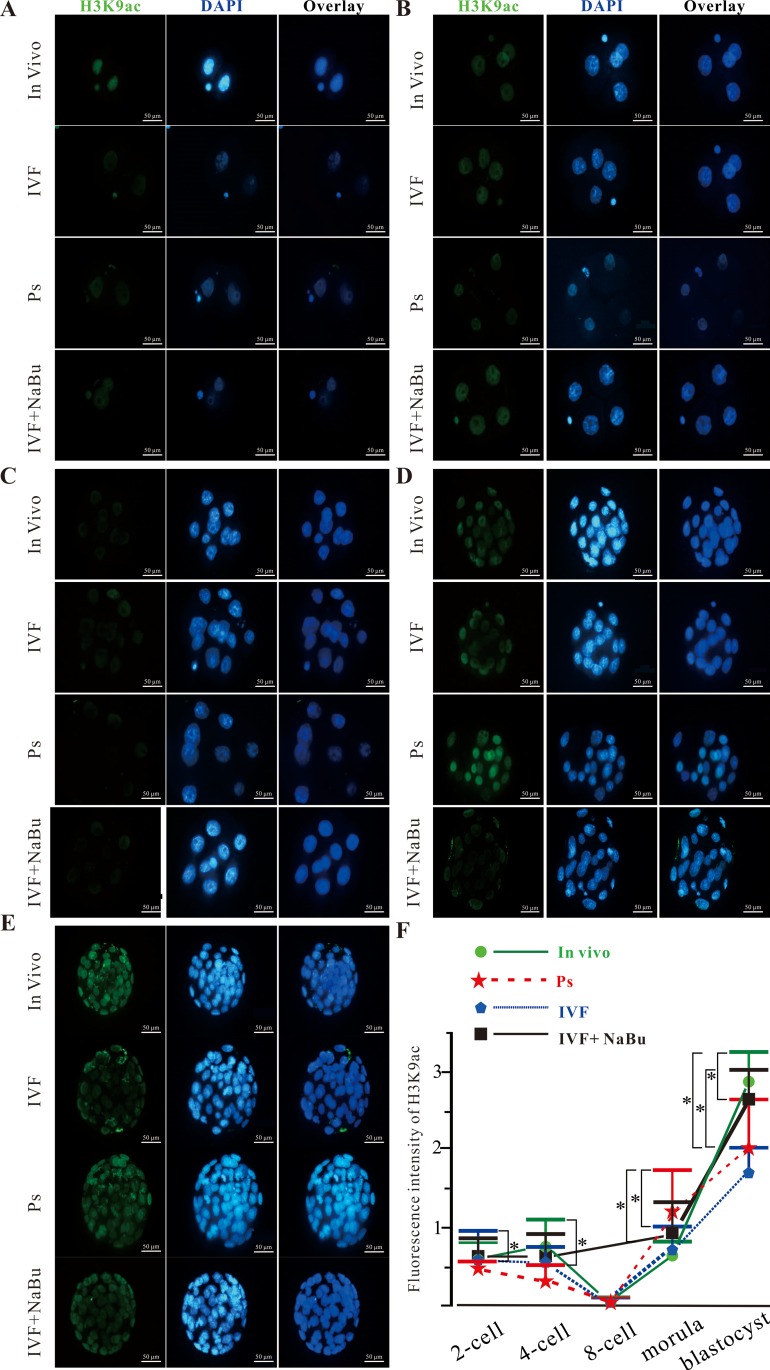
Acetylation status of H3K9 during the preimplantation development of embryos derived from in vivo, Ps, IVF, and IVF+NaBu.Embryos derived from in vivo, Ps, IVF, and IVF+NaBu were obtained to analyze the expression of H3K9ac using immunofluorescence technology. Immunofluorescent images of embryos at the 2-cell (A), 4-cell (B), 8-cell stage (C), morula (D), and blastocyst (E) stages that were immunostained using anti-H3K9ac antibody (green). The DNA was counterstained with DAPI (blue). (F) Summary data of H3K9ac fluorescence in (A-E). *: P < 0.05.